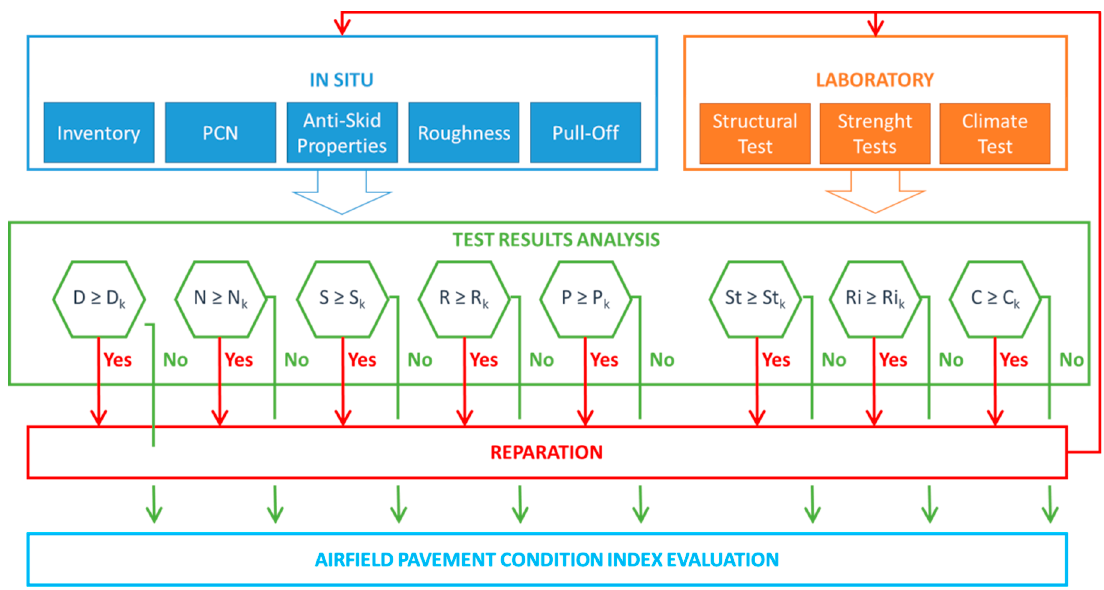
Figure 6. Diagram of the procedure for assessing the technical condition of an airport pavement using the APCI indicator.